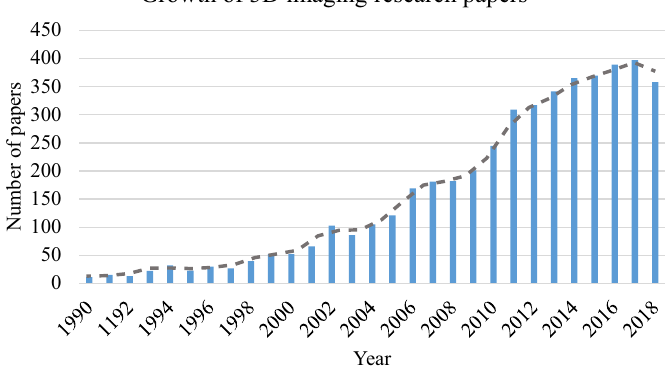
Figure 1. Number of papers with a title containing “3D imaging” in Google Scholar during the past decades.